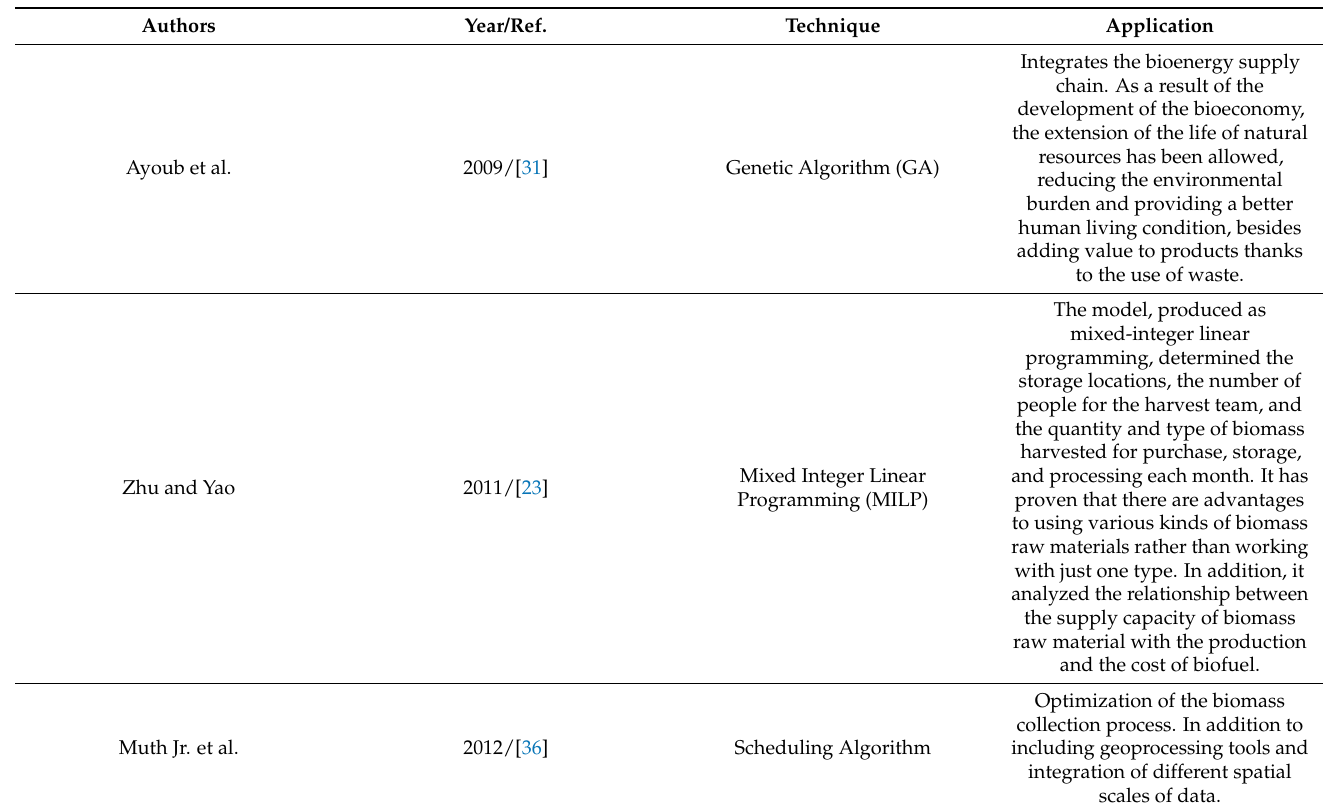
Table A1. Algorithm models identified in the analysis portfolio as well as their applications and expected results from 2009 to